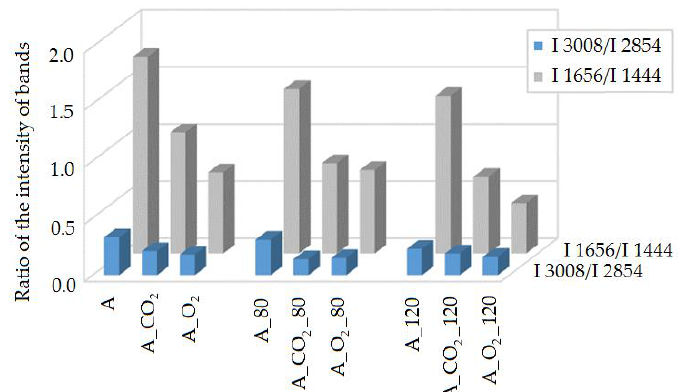
Figure 6. The influence of oxidation on the change in fatty acids unsaturation degree of the researched oils before and after oxidation, at 80 °C and 120 °C, expressed by I 1656 /I 1444 and I 3008 /I 2854 band intensity ratio.